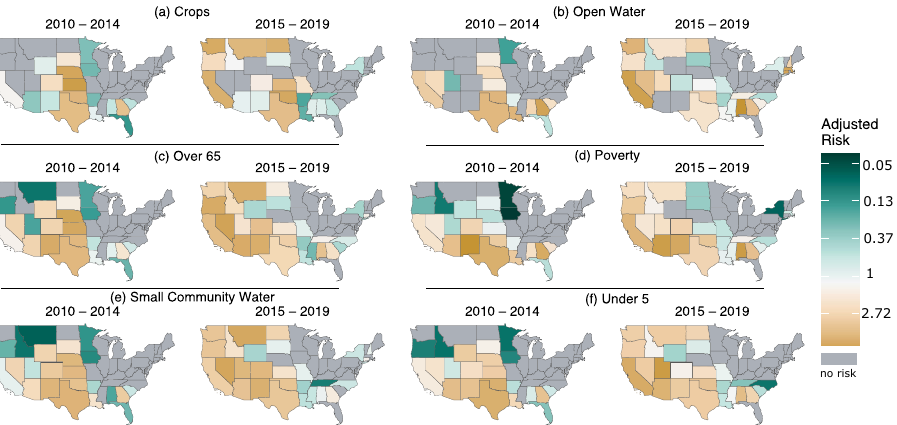
Figure 4. Adjusted risk values for each state. Gray states contain no counties in (high vulnerability|high hazard) risk condition. Darker green values indicate that the state has a lower risk, and brown indicates a higher risk. Values are calculated by dividing the state level ratios of a number of counties in high vulnerability|high hazard clustering to all counties to the similar national level.